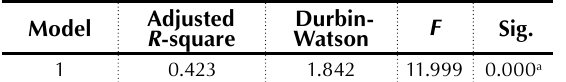
Table 4. Model summary